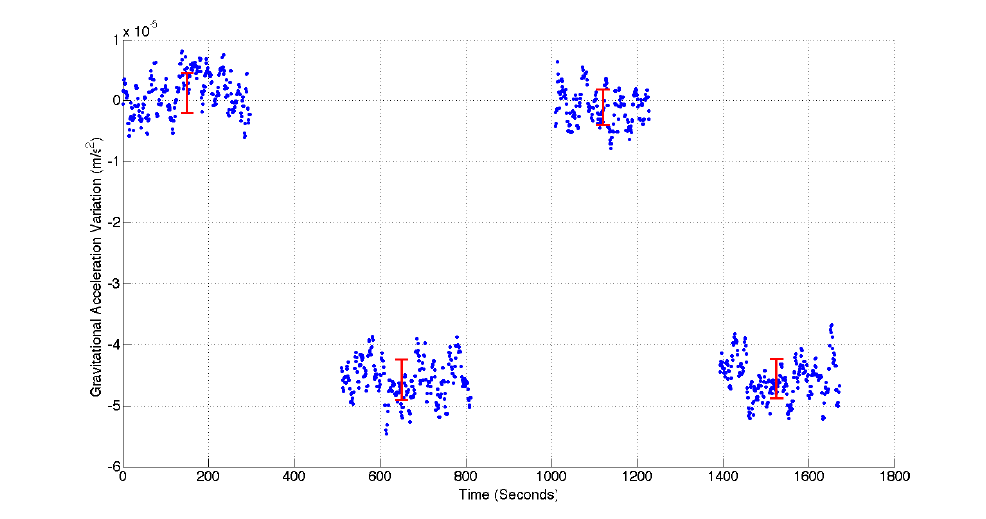
Figure 6. The change in gravitational acceleration observed between the bottom and top of a 20.73 m lift shaft, with two measurements conducted in each position. The zero point of the data has been set as the level measured at the bottom of the lift shaft. An acceleration change of 4.51 × 10 − 5 ms − 2 is observed between the top and bottom of the building. The data has been cut in between each of the measurements since this just shows the inertial acceleration caused by the motion of the lift. The red data points are the mean acceleration value of each measurement location. The error bars of these points demonstrate the standard deviation of each respective